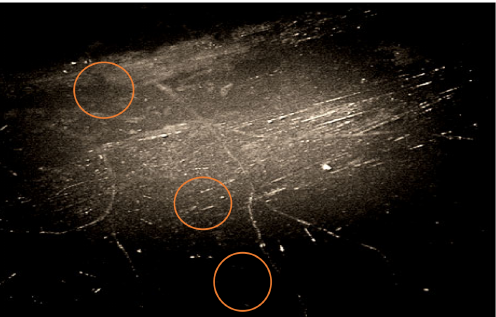
Figure 5. Image of the mycelium of fungi of the genus Aspergillus , germinating from the wall of the BFRP rebar and the cells of bacteria of the genus Bacillus , biologically infected sample BFRP rebar after climatic test, polarizing microscopy, × 1000 magnification.